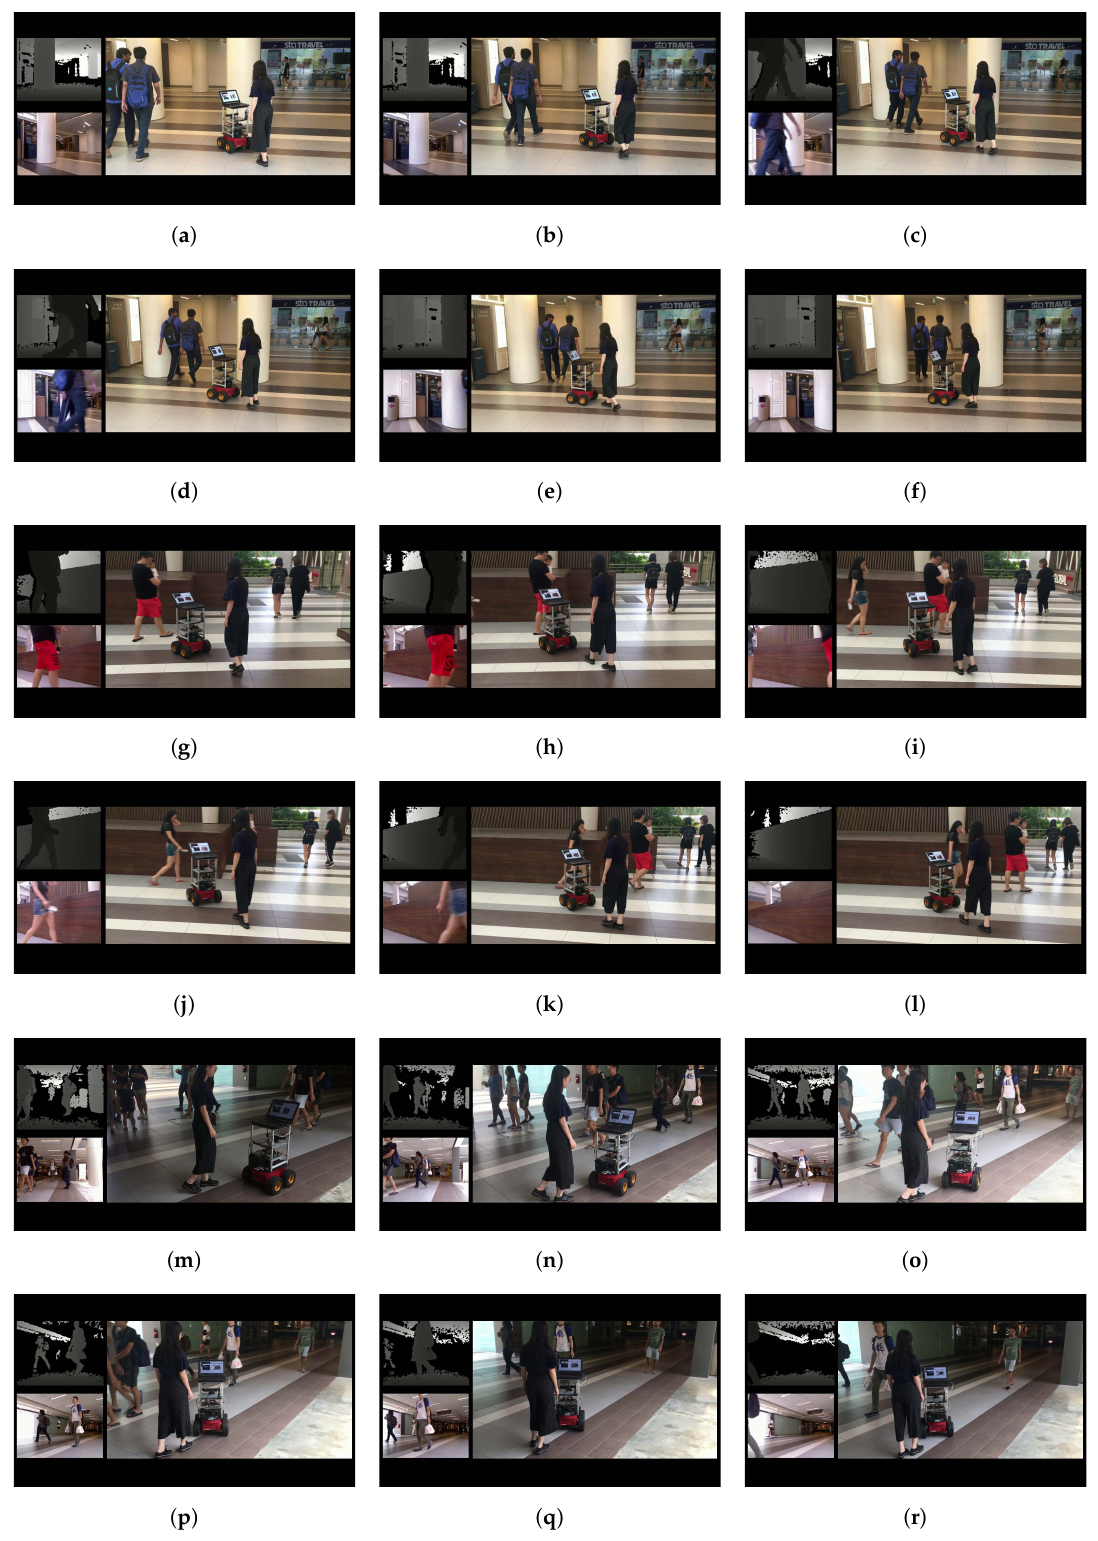
Figure 9. Examples in dynamic environments. For each example, six intermediate steps are demonstrated in sequence. For each step, the third-person view is shown on the right and the corresponding depth image and first-person view are displayed in the top and bottom left corners, respectively. ( a – f ) Show the process to avoid collision with two walking persons. ( g – l ) Describe the process to avoid a group of people separately. ( m – r ) Illustrate an example of traveling through a